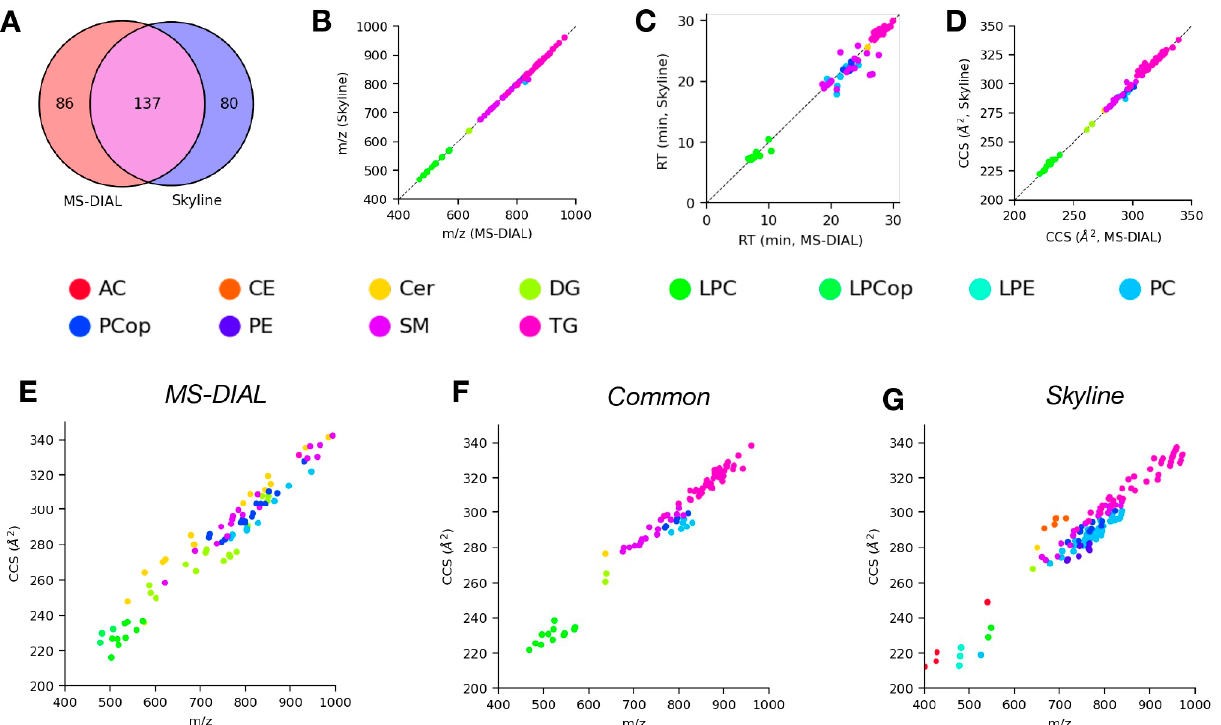
Figure 2. Comparison of lipid identifications from analysis of positive mode LC-DTIMS-MS/MS lipidomics data using Skyline and MS-DIAL. ( A ) Venn diagram of lipids identified using either software. ( B – D ) Comparisons of m / z ( B ), retention time ( C ), and CCS ( D ) values from MS-DIAL vs. Skyline for common lipid identifications from both tools, points colored according to lipid class. ( E , F ) CCS trend lines or IMS-MS conformational space of lipids identified by MS-DIAL ( E ), Skyline ( G ), or both tools ( F ), points colored according to lipid class.